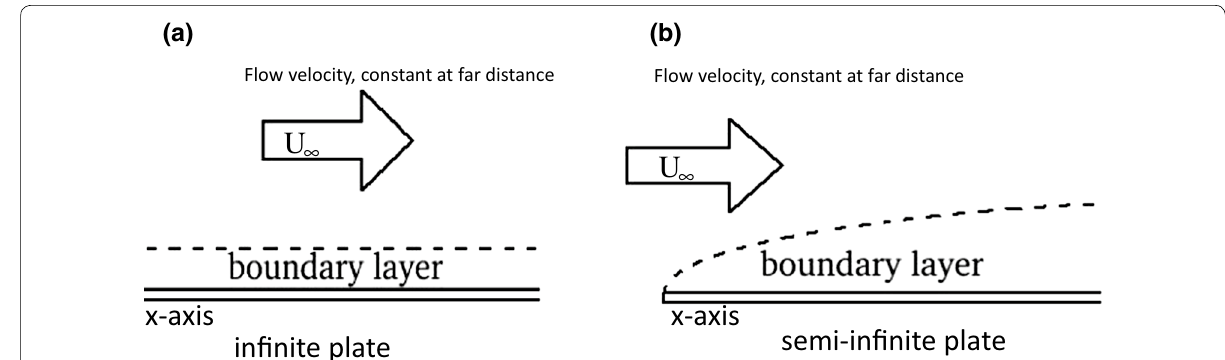
Fig. 1 Illustrations of the two boundary layer models of two‑dimensional laminar flow. Dashed lines separate the zero and nonzero domains of the velocity gradient of flow. a The infinite plate model, and b the semi‑infinite plate model. The flat plate is fixed in x ‑direction, and fluid starts to flow parallel to the plate at a certain moment. U ∞ denotes the flow velocity at far distance, which is parallel to the plate